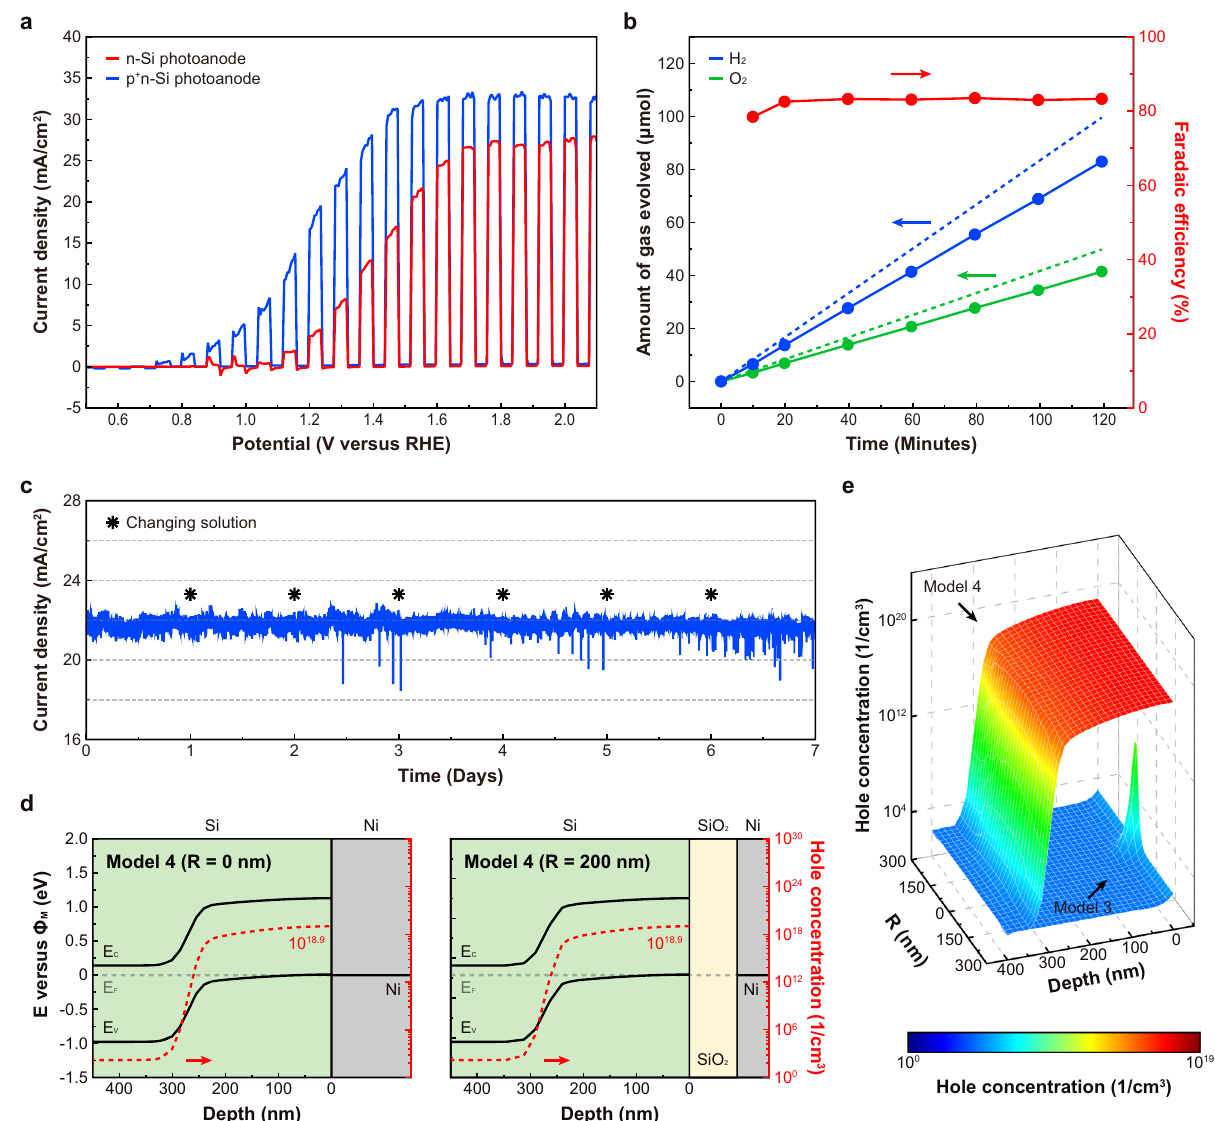
Fig. 6 PEC characterization and simulations for the spiked Ni/SiO 2 /p + n-Si photoanode. a LSV curves obtained in 1 M KOH solution with chopped AM1.5G illumination for spiked Ni/90 nm SiO 2 /n-Si (red) and spiked Ni/90 nm SiO 2 /p + n-Si (blue) photoanodes. b Ideal (dotted lines) and measured (solid lines and symbols) evolution of H 2 and O 2 gases during OER activity at 1.23 V versus RHE for 120 min. The Faradaic ef fi ciency was calculated for O 2 gas evolution. c 7-days CA stability test at − 1.3 V versus RHE in 1 M KOH solution. d Simulated band diagrams and hole concentrations for Model 4 for R = 0 nm and R = 200 nm. e Simulated hole concentration near the spiked area for Models 3 and